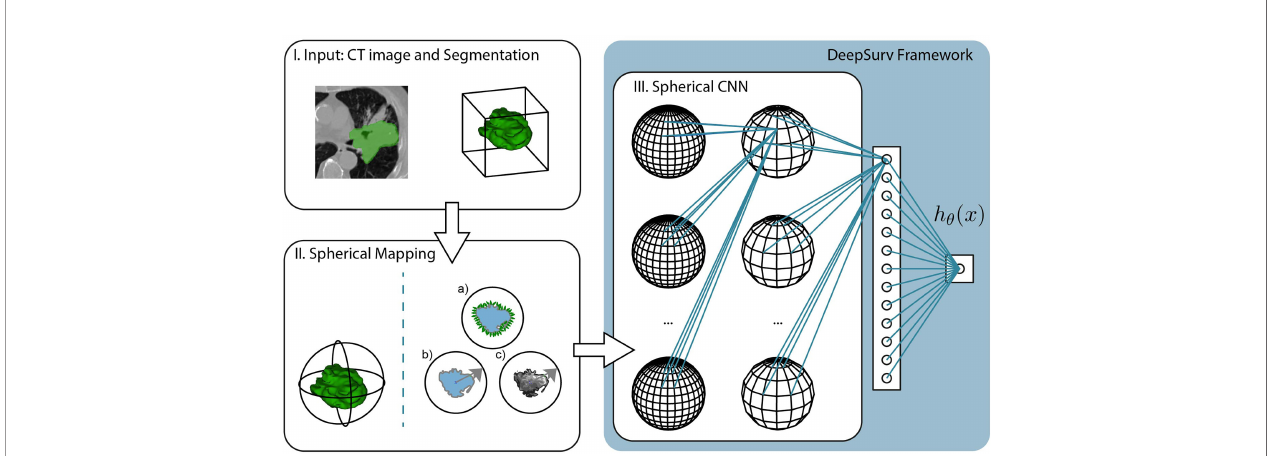
FIGURE 3 | Pipeline of the proposed method, which is divided into three steps. I. The input consists of the CT image and segmentation of the tumor mass. The experiments compare the predictive performance of provided manual segmentation masks with our automatic segmentation. II. The volumetric images are projected into the spherical domain to be usable with Spherical CNNs. In this study, we propose three spherical mappings; a) the extended Gaussian image (EGI), b) the depth-based projection of the mask (b), and c) the spherical intensity mapping of the masked image content. III. The Spherical CNN consists of a cascade of spherical kernel stacks followed by spherical pooling operations. The Spherical CNN is embedded in the DeepSurv framework that includes a fully connected layer that pass the activation signal to a single output node. This scalar output is the approximation of the log-risk function h q ( x ) in Cox proportional hazards model which is optimized through